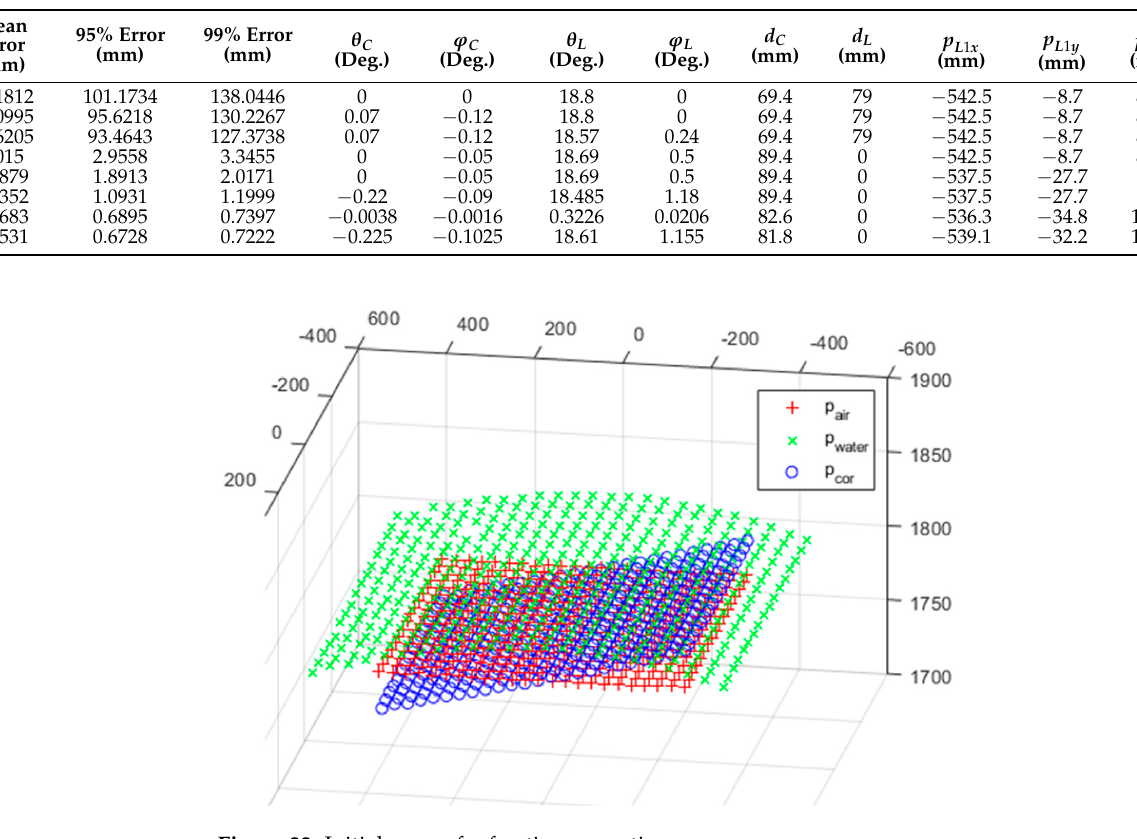
Figure 24. Measurement error. 5. Conclusions 3D imaging equipment required by the remote decommissioning system in the field of nuclear power plant decommissioning was successfully developed using an industrial 3D scanner. The 3D imaging equipment can survive up to a cumulative dose of 1 kGy and measure a 3D point cloud in air and in water. The measured 3D point cloud is accurate enough to estimate the position of a target object with an error of less than 1 mm. To achieve the goal, we selected a suitable industrial 3D scanner, designed a housing struc- ture for water and radiation protection, and provided radiation protection through shield- ing and accuracy improvement through refraction correction. We proved the validity of the optical path configuration using mirrors, the shielding thickness calculation method, and the refraction modeling equations through the experimental results. The proposed method is expected to contribute to various applications requiring 3D imaging equipment in radioactive or underwater environments.